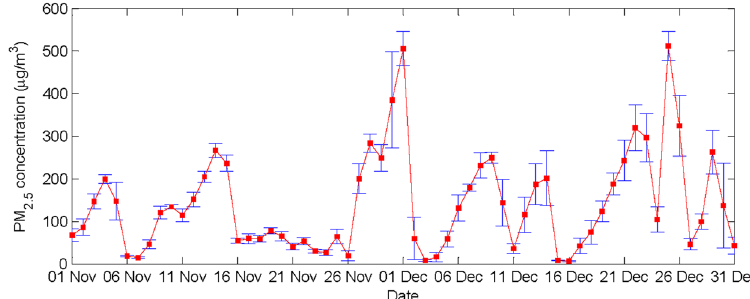
Figure 2. The daily mean PM 2.5 concentrations in downtown Beijing over November-December 2015. Error bars denote the standard deviations calculated from 24 hours of recorded data.